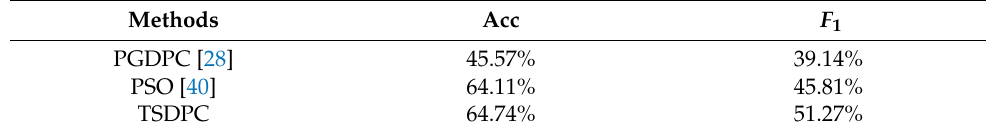
Table 2. Evaluation indicators data statistics of three clustering algorithms on the public